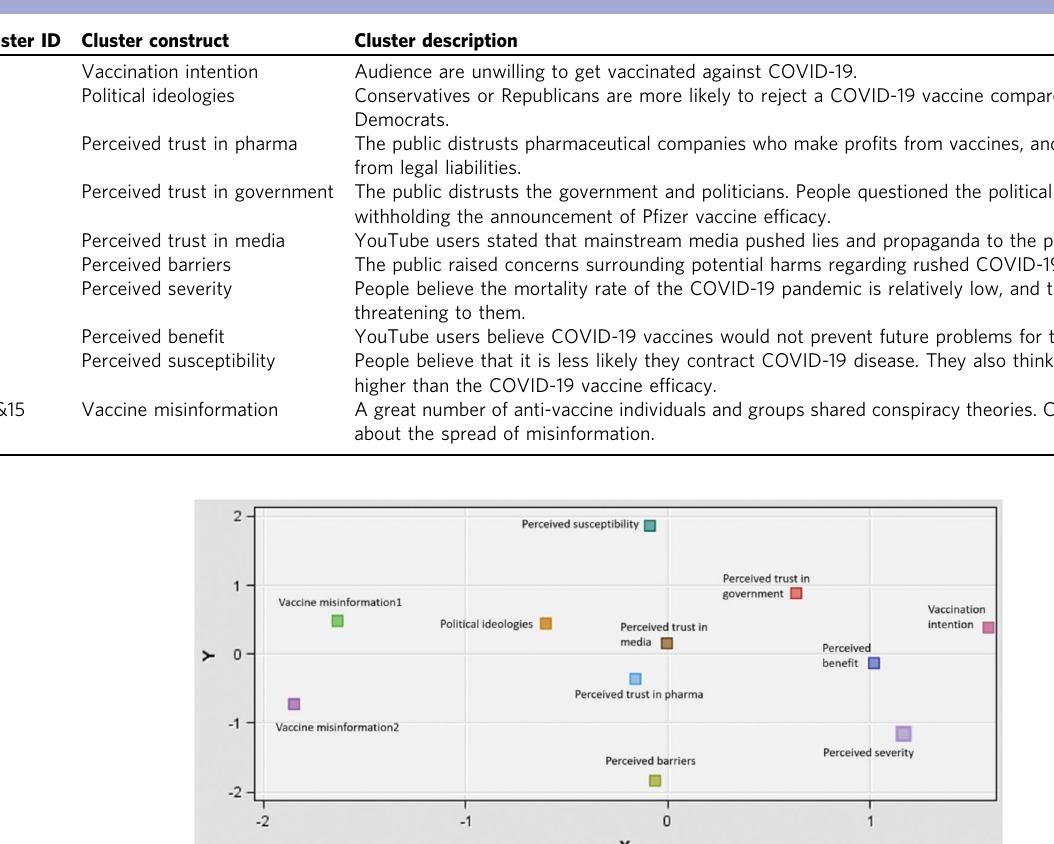
Table 5 Constructs of the study